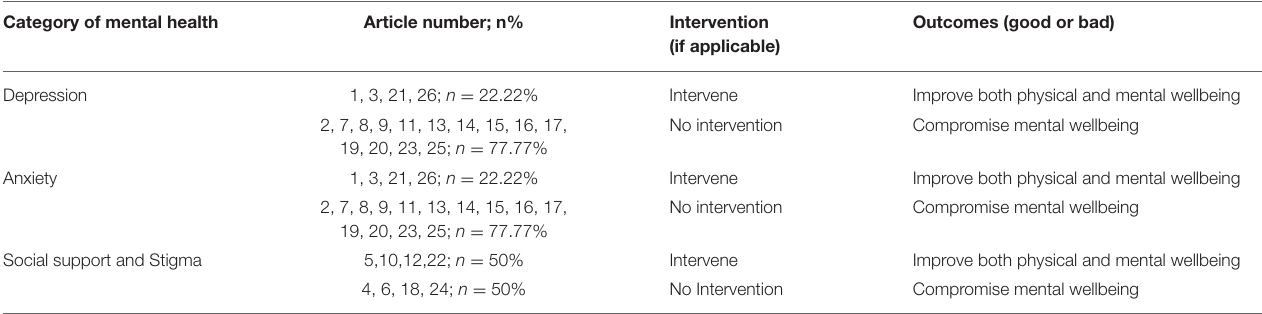
TABLE 3 | Interventional